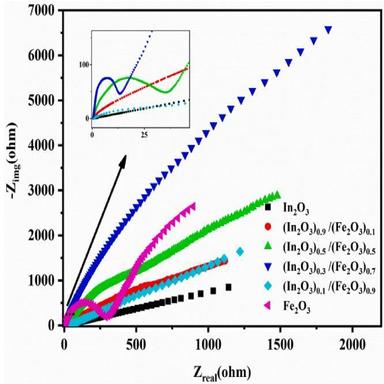
Nyquist plot for the Fe2O3, In2O3, and their nanocomposites.